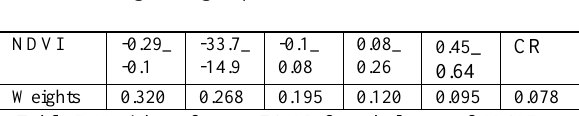
Table 4. Weights of group FAHP for subclasses of TPI